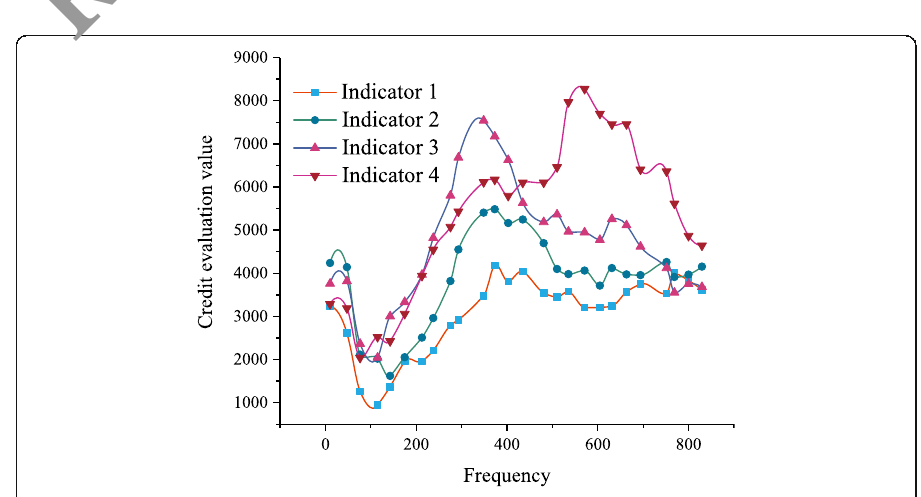
Fig. 7 Changes in personal credit information